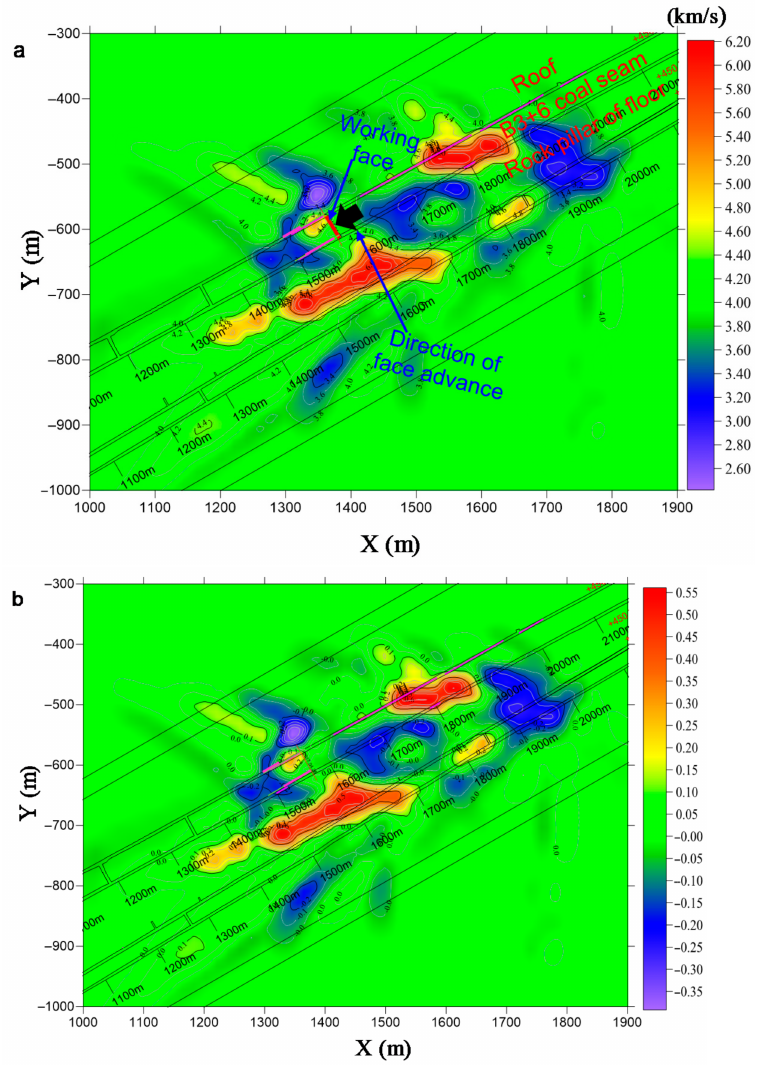
Figure 15. Tomographic images obtained using MS events on 22 April 2017 (with the 125 MS events that occurred). ( a ) Velocity inversion result, ( b ) Velocity anomaly inversion